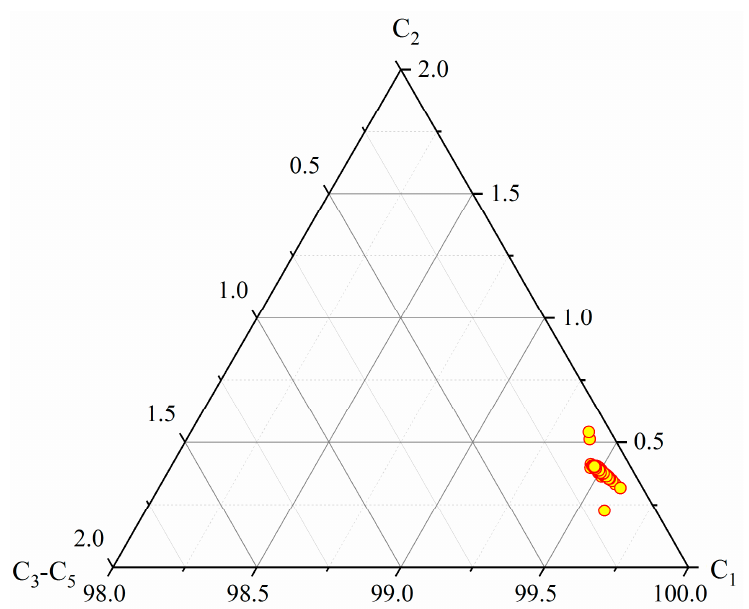
Figure 3. Ternary diagram of hydrocarbons from China’s first offshore gas hydrate production test in SCS. All of the data points fall into the C1 end member, which indicate that methane is the main component of gas.